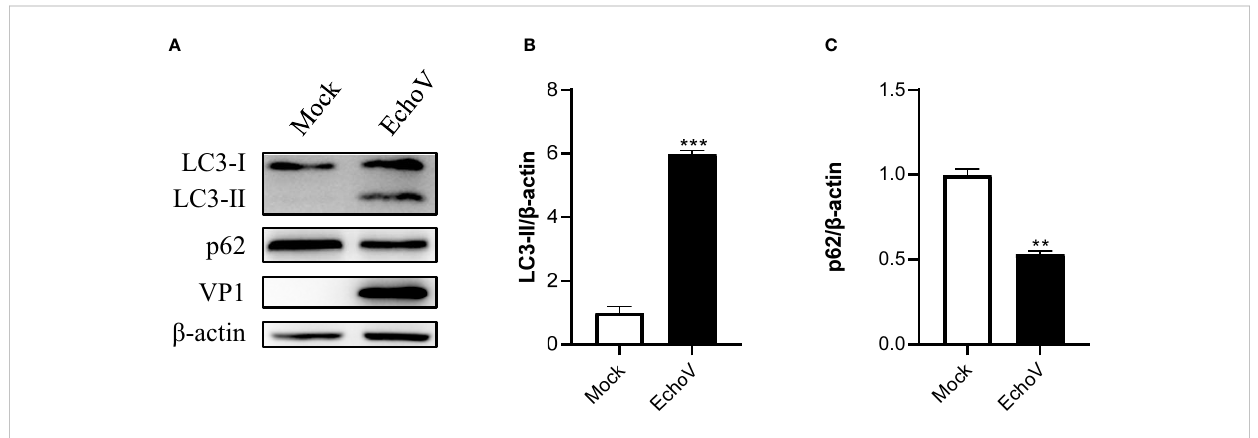
FIGURE 1 Echovirus infection induces autophagy. RD cells were infected or not (Mock) with echovirus 11 at 1 MOI for 1.5 h. At 16 h post-infection, cells were then harvested. (A) Intracellular LC3 and p62 proteins were detected via western blotting. b -actin served as a loading control. This result is representative of three independent experiments. The relative band intensities of detected proteins were calculated using ImageJ from NIH, and the result was represented as the ratio of LC3-II to b -actin (B) or p62 to b -actin (C) . A one-way ANOVA was used to determine statistically signi fi cant differences in multiple comparisons. **p<0.01, *** P